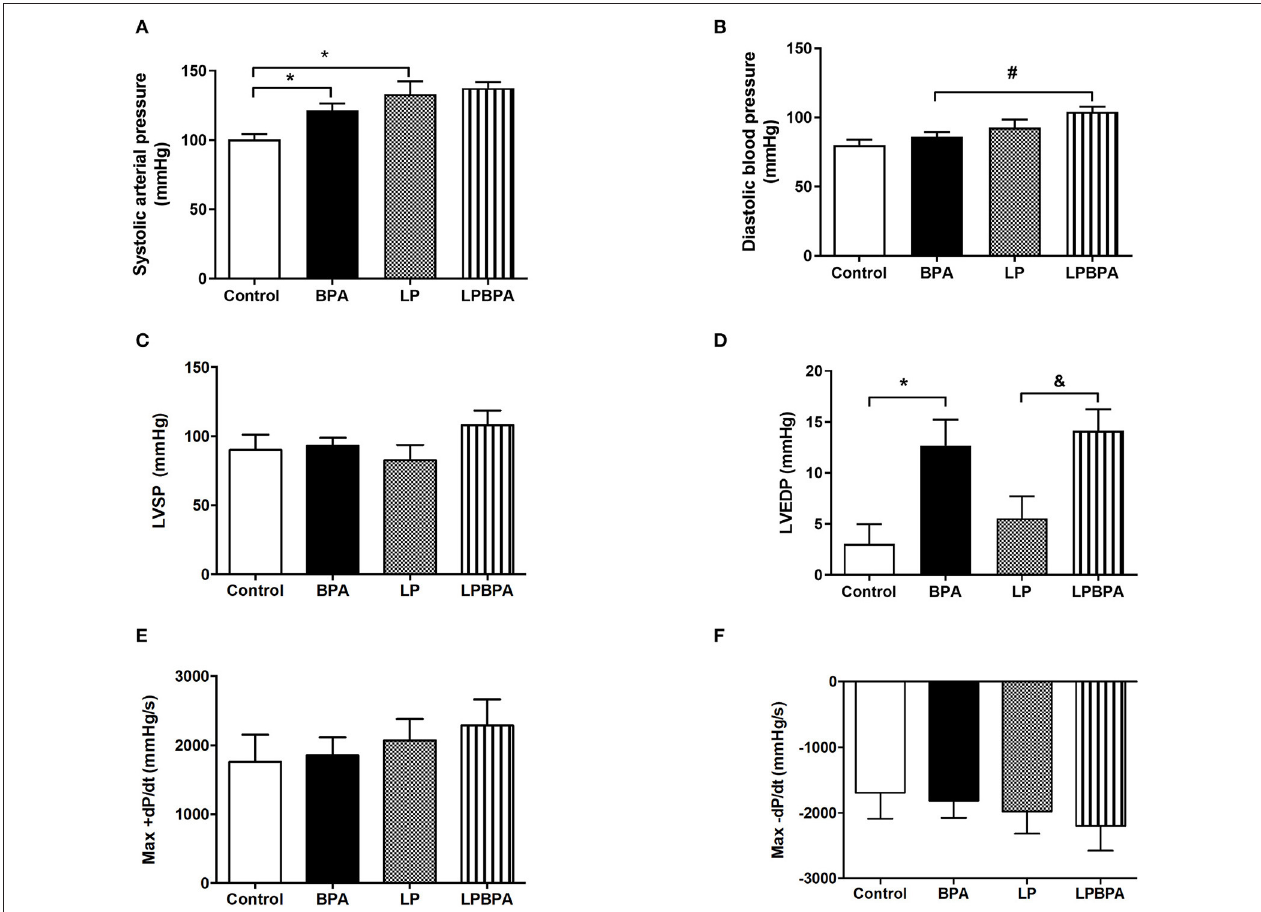
FIGURE 1 | Effects of bisphenol A (BPA) exposure and low protein (LP) diet in hemodynamic parameters. Systolic (A) and diastolic (B) blood pressure, left ventricular (LV) systolic pressure (LVSP) (C) , end diastolic pressure (LVEDP) (D) , and maximum positive (Max + ) (E) and negative (Max-) (F) pressure derivatives (d P /d t ) in mice fed normoprotein (control) or LP diet during 8 weeks and exposed to BPA for 9 days. Data are expressed as the mean ± SEM (number of animals/group: Control = 8; BPA = 5; LP = 5; LPBPA = 5). One-way ANOVA followed by the Newman-Keuls test, * p < 0.05 vs. control; & p < 0.05 vs. LP; # p < 0.05 vs.